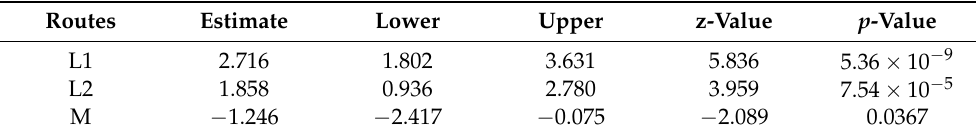
Table 4. The parameters of the GLM model on the duration of elevated exposure.